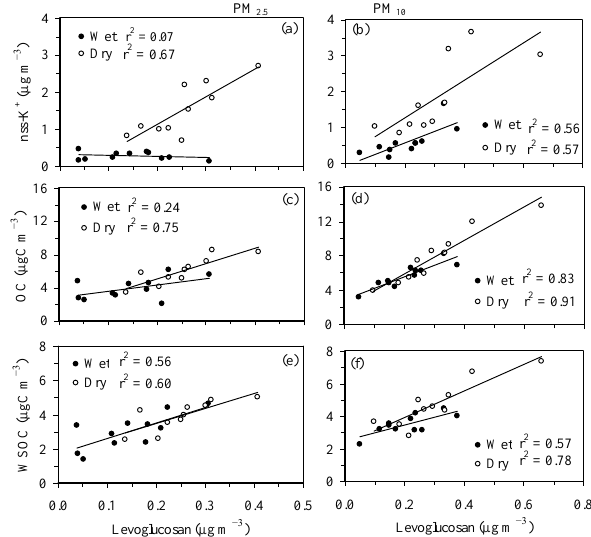
Fig. 10. The relationship between levoglucosan and nss-K + , OC and WSOC in PM 2 . 5 (a, c, e) and PM 10 (b, d, f) at Morogoro during the wet and dry